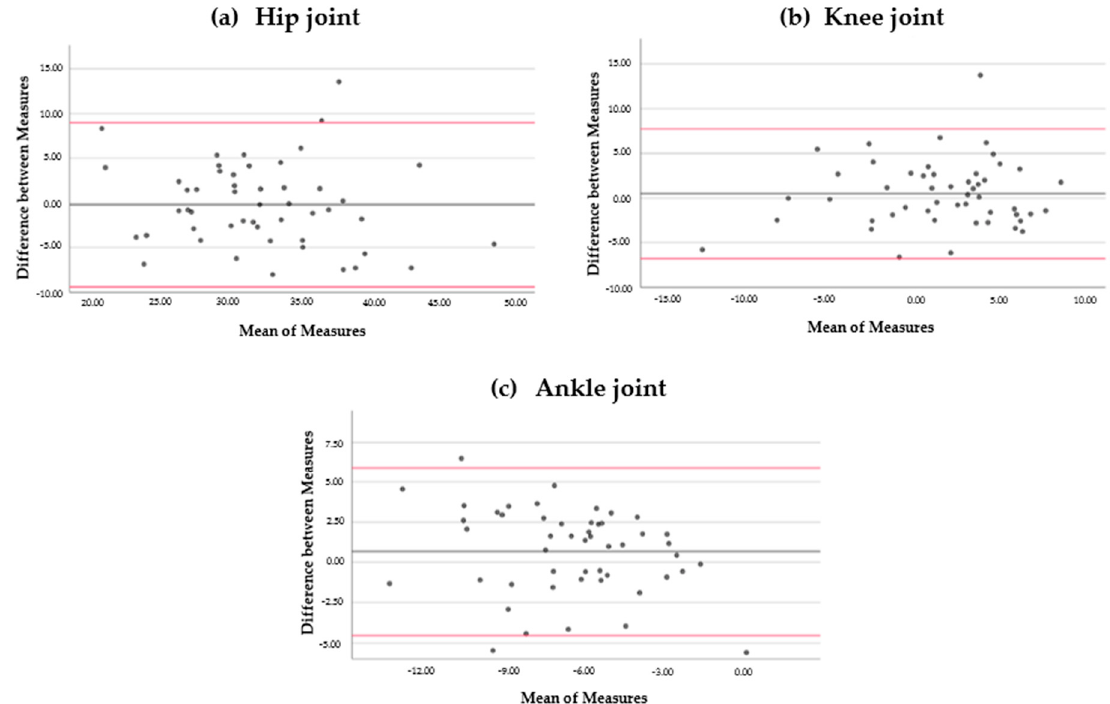
Figure 1. Bland–Altman plots. Difference between measurements for hip angles ( a ), knee angles ( b ), and ankle angles ( c ) during initial contact. Bias (black line) and limits of agreement (red lines) are indicated. The mean score is shown on the x -axis, and the difference between measures (and the mean of the differences) is shown on the y -axis (mean difference ± 1.96 SD).